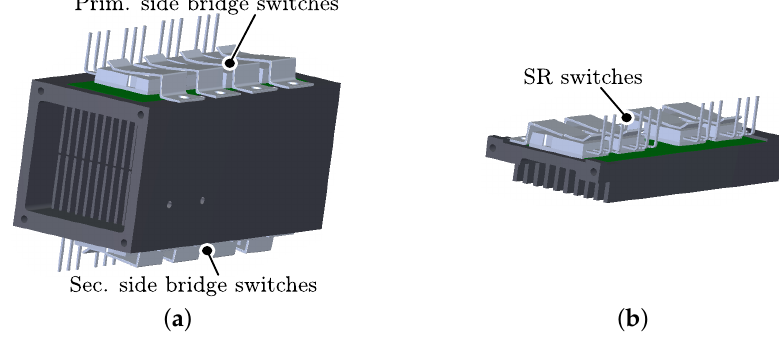
Figure 8. Heat sink-semiconductor assemblies for ( a ) the DAB and ( b ) the synchronous rectifier (SR).